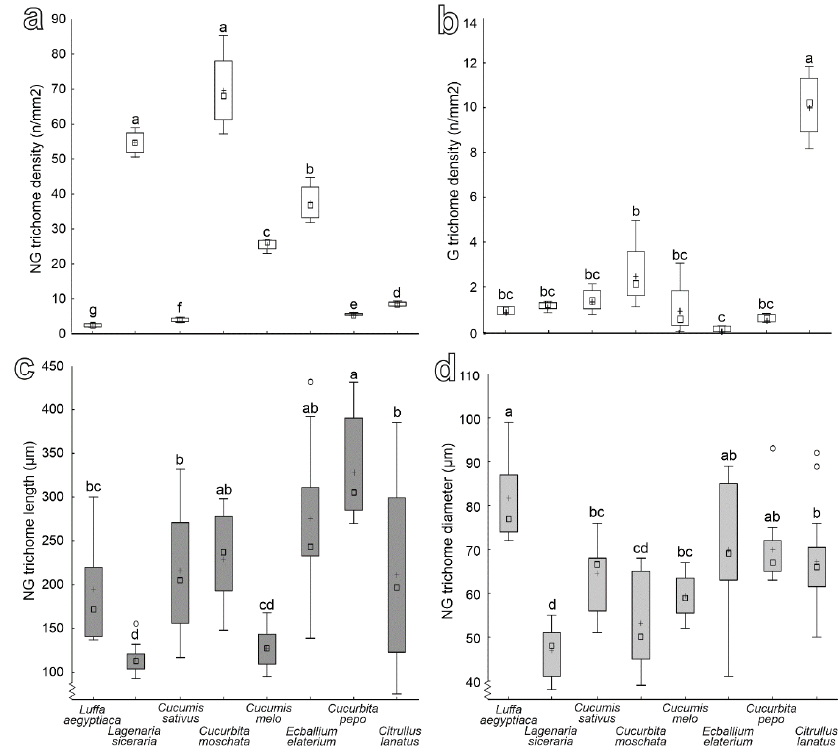
Figure 7. Density of non-glandular ( a ) and glandular trichomes ( b ) and length ( c ) and diameter ( d ) of non-glandular trichomes in the different Cucurbitaceae plant species. Boxplots show the interquartile range and the medians; whiskers indicate 1.5 × interquartile range, “ ◦ ” is outlier and “+” shows the mean. Boxplots with different letters are significantly different at p < 0.05 (Tukey unequal N HSD post hoc test, one-way